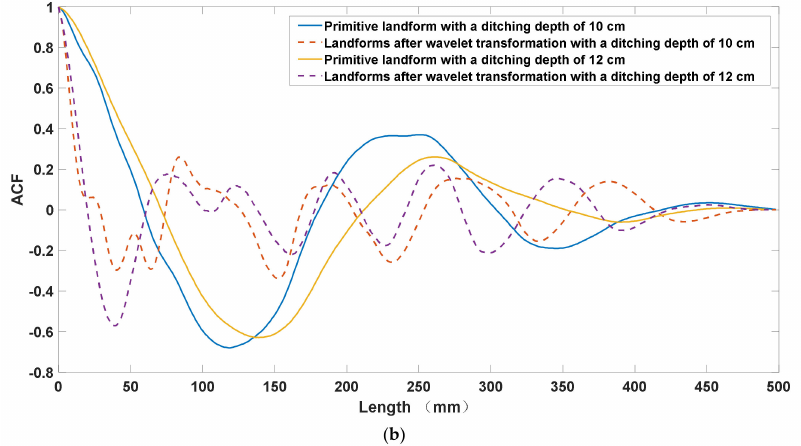
Figure 11. The ACF of the original surface and the soil surface after wavelet transform under different ditching depths. ( a ) Ditching depth of 5 cm and 8 cm. ( b ) Ditching depth of 10 cm and 12 cm.